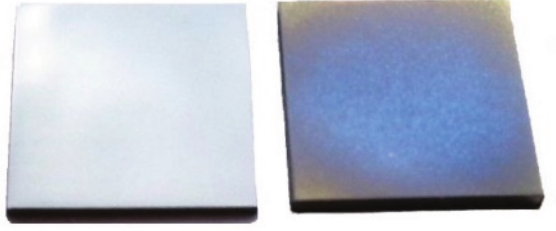
Figure 3. Uncoated, polished titanium substrate ( left ) and chitosan-tripolyphosphate spray-coated titanium substrate ( right